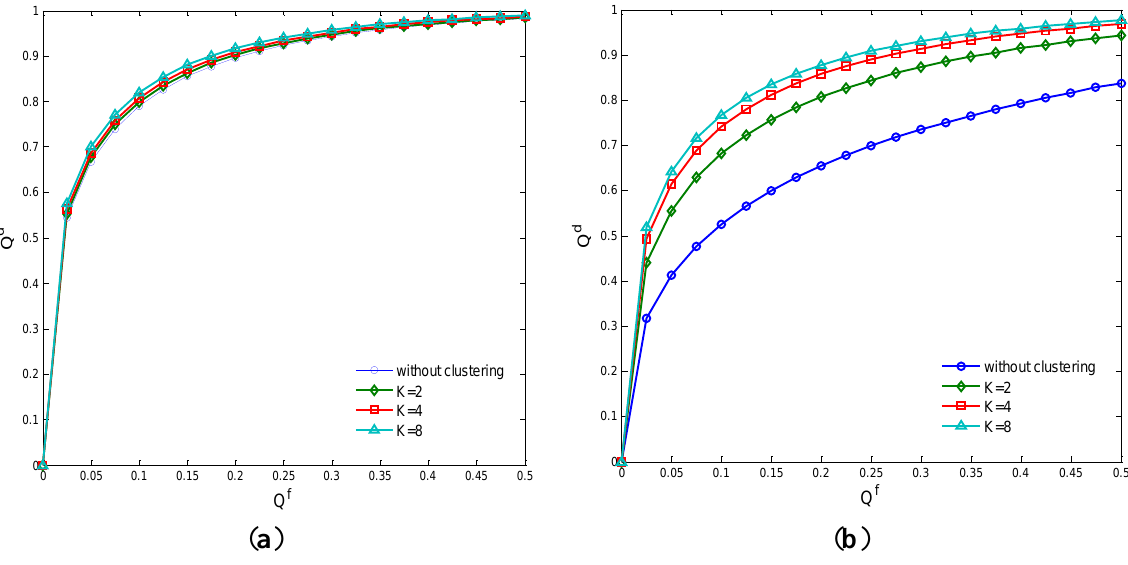
Figure 7. Detection probability with different clustering number. ( a ) Perfect channel; ( b ) Rayleigh fading channel.